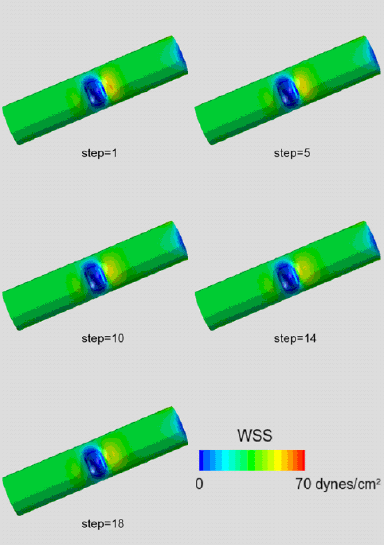
Fig. 3 Progression of aneurysm of the straight model. Only slight development of the aneurysm is observed. Simulation condition: k=1.5 and τ